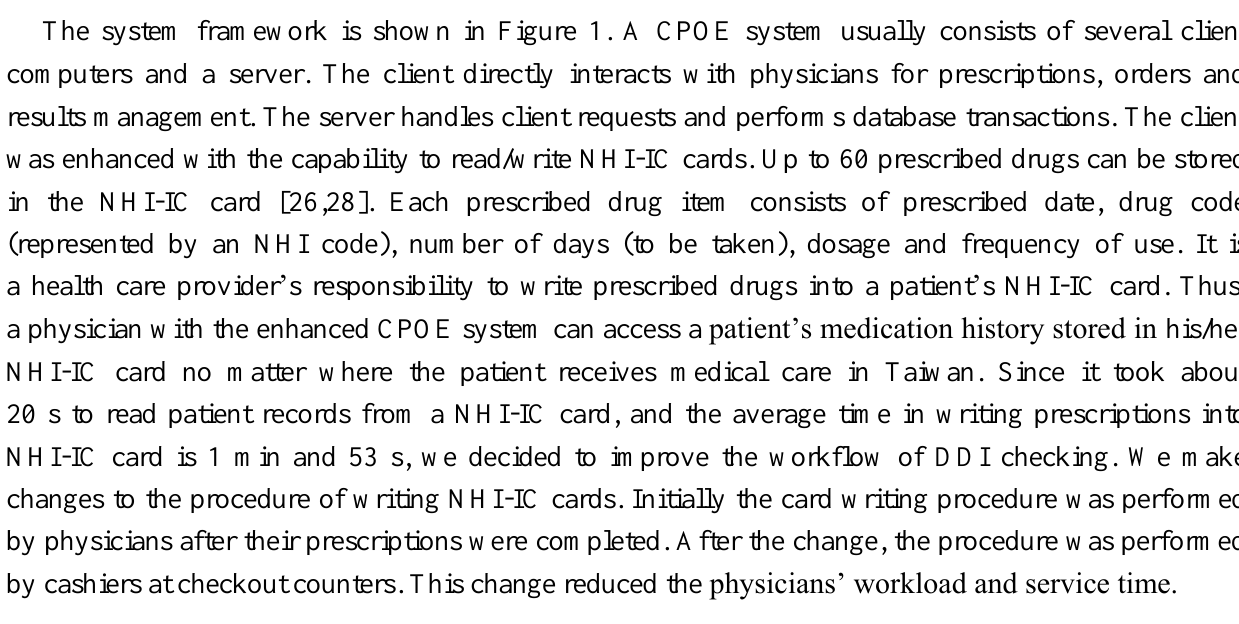
Figure 1. The framework of potential DDIs detection across